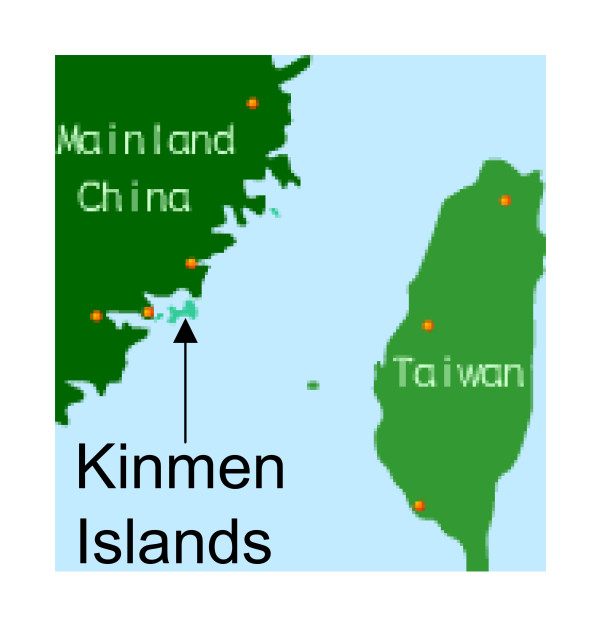
Geographic location of Kinmen between Taiwan and mainland China.